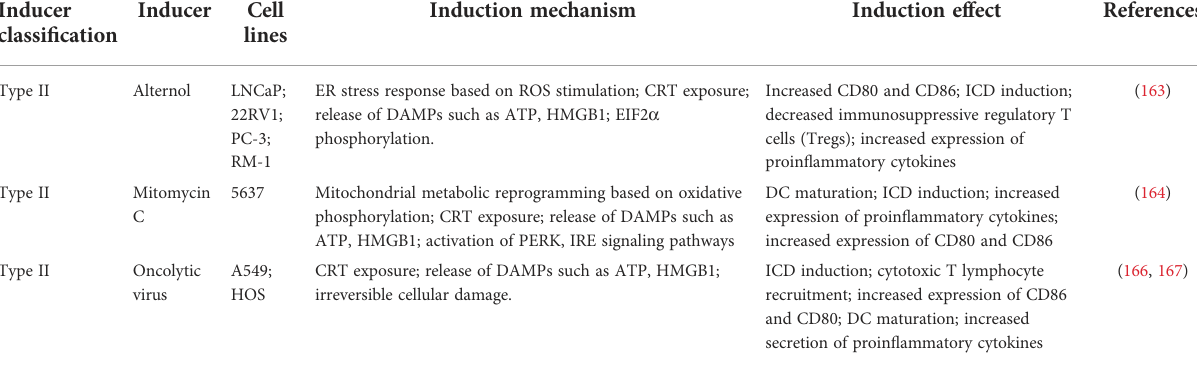
TABLE 3 Pathogen-derived ICD inducers. Inducer classi fi cation